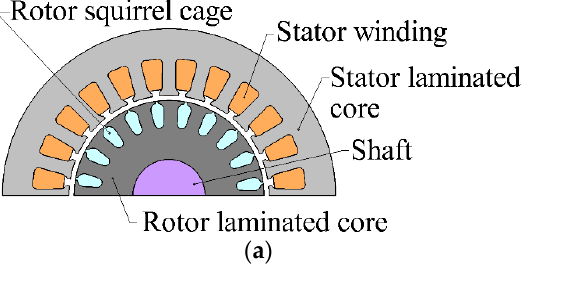
Figure 1. Motor sketches: ( a ) induction motor (IM); ( b ) line-start permanent magnet synchronous motor (LSPMSM).